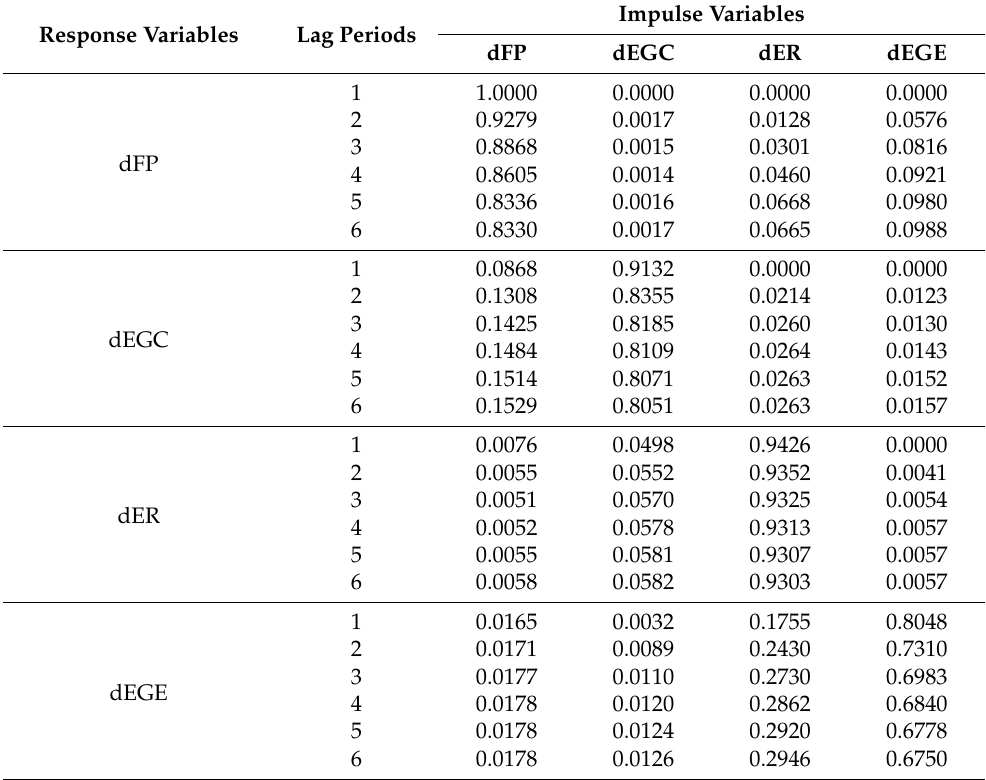
Table 6. Results of variance